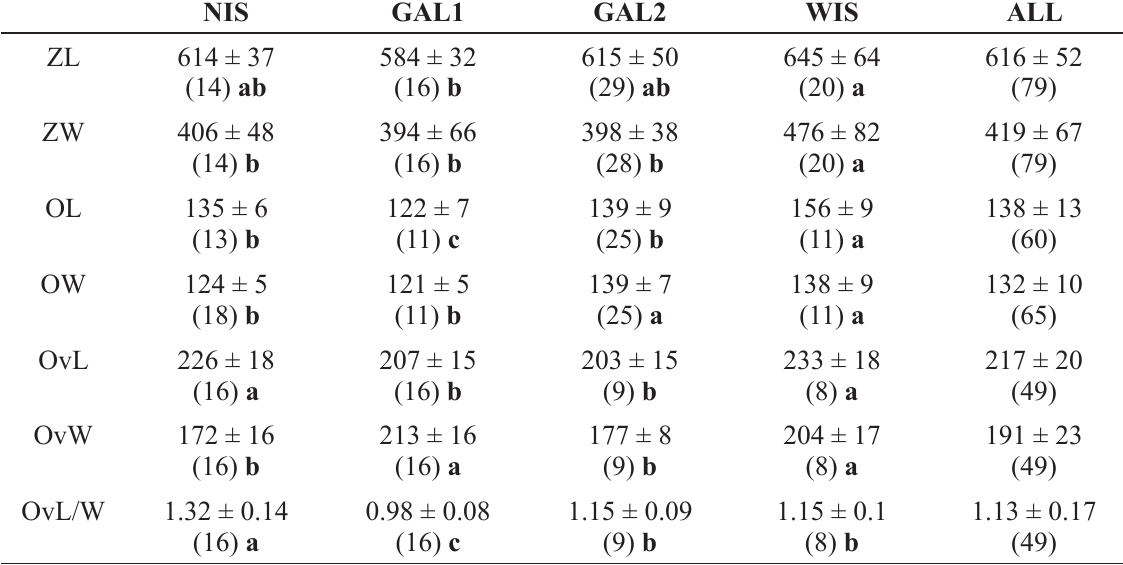
Table 7. Morphometric comparison between different populations of Atlantisina tricornis gen. et sp. nov., from the N Iberian slope (NIS), two from Galicia Bank (GAL1, GAL2), and from the W Iberian slope (WIS). All data combined are given under ALL. The measurements are given as the mean ± standard deviation and the number of measurements taken (in parentheses). The subsequent letter (in bold) represents the results of the intergroup comparison of means using a post hoc Tukey’s test; groups not connected by the same letter are significantly different, those with two letters (ab) are